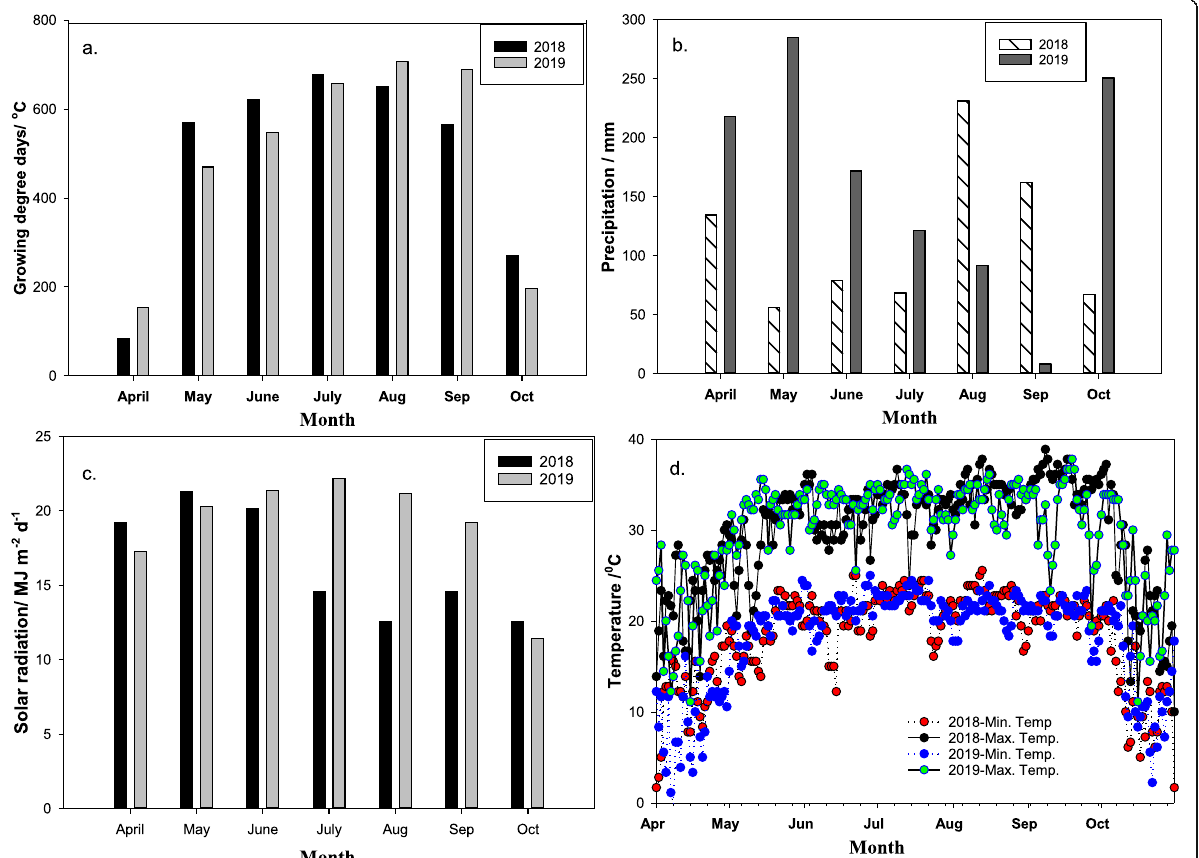
Fig. 1 Measured ( a ) growing degree days (GDD), ( b ) precipitation, ( c ) solar radiation, and ( d ) air temperature for 2018 and 2019 cotton